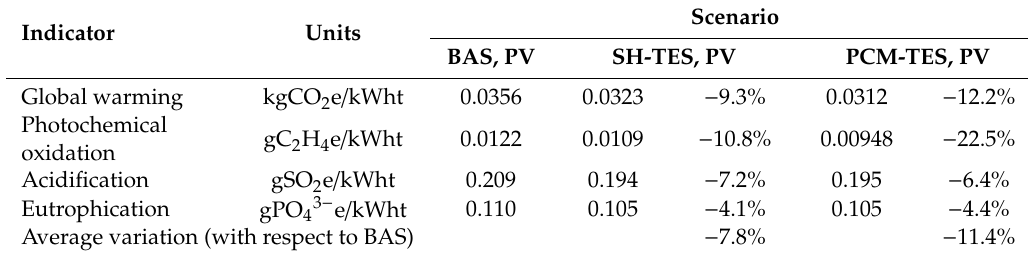
Table 5. Mid-point indicators for the three scenarios (electricity from photovoltaic sources).